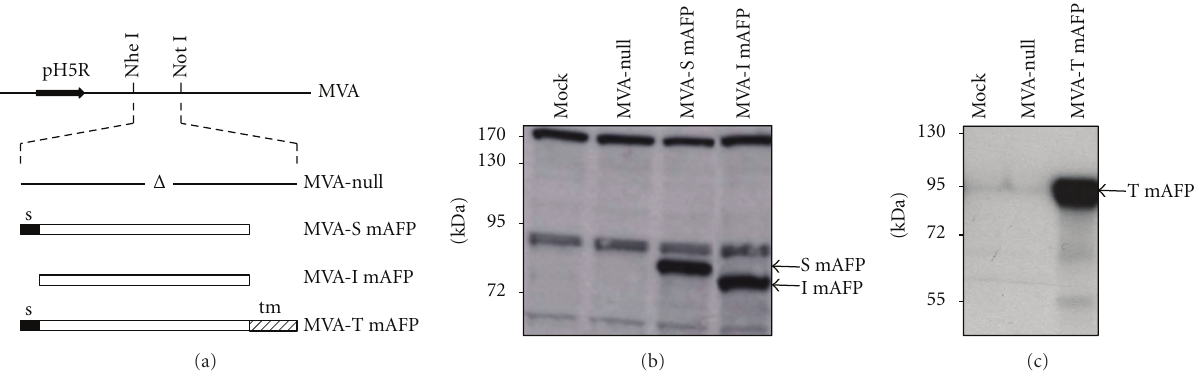
Figure 1: Generation of recombinants MVA expressing the di ff erent murine AFP sequences and evaluation of the mAFP proteins expression. (a) Schematic representation of transgenes inserted into the MVA genome. The di ff erent AFP sequences are under the control of the early- late promoter pH5R. Δ : no insert; s: exporting sequence; tm: transmembrane domain; (b) specific detection of modified AFP proteins on western blot by polyclonal antibody directed against the C-terminal AFP protein. Lane 1 (left to right): mock-infected CEP cells; Lane 2: CEP cells infected with MVA-null; Lane 3: CEP cells infected with MVA-s mAFP; Lane 4: CEP cells infected with MVA-I mAFP. Molecular weight standards are shown in kDa on the left. The presence of the intracellular AFP protein (I mAFP) and of the secreted AFP protein (S mAFP) is indicated (arrows). (c) Specific detection of transmembrane AFP protein on western blot by antibody directed against the transmembrane domain. The presence of the transmembrane AFP protein (T mAFP) is indicated (arrow).